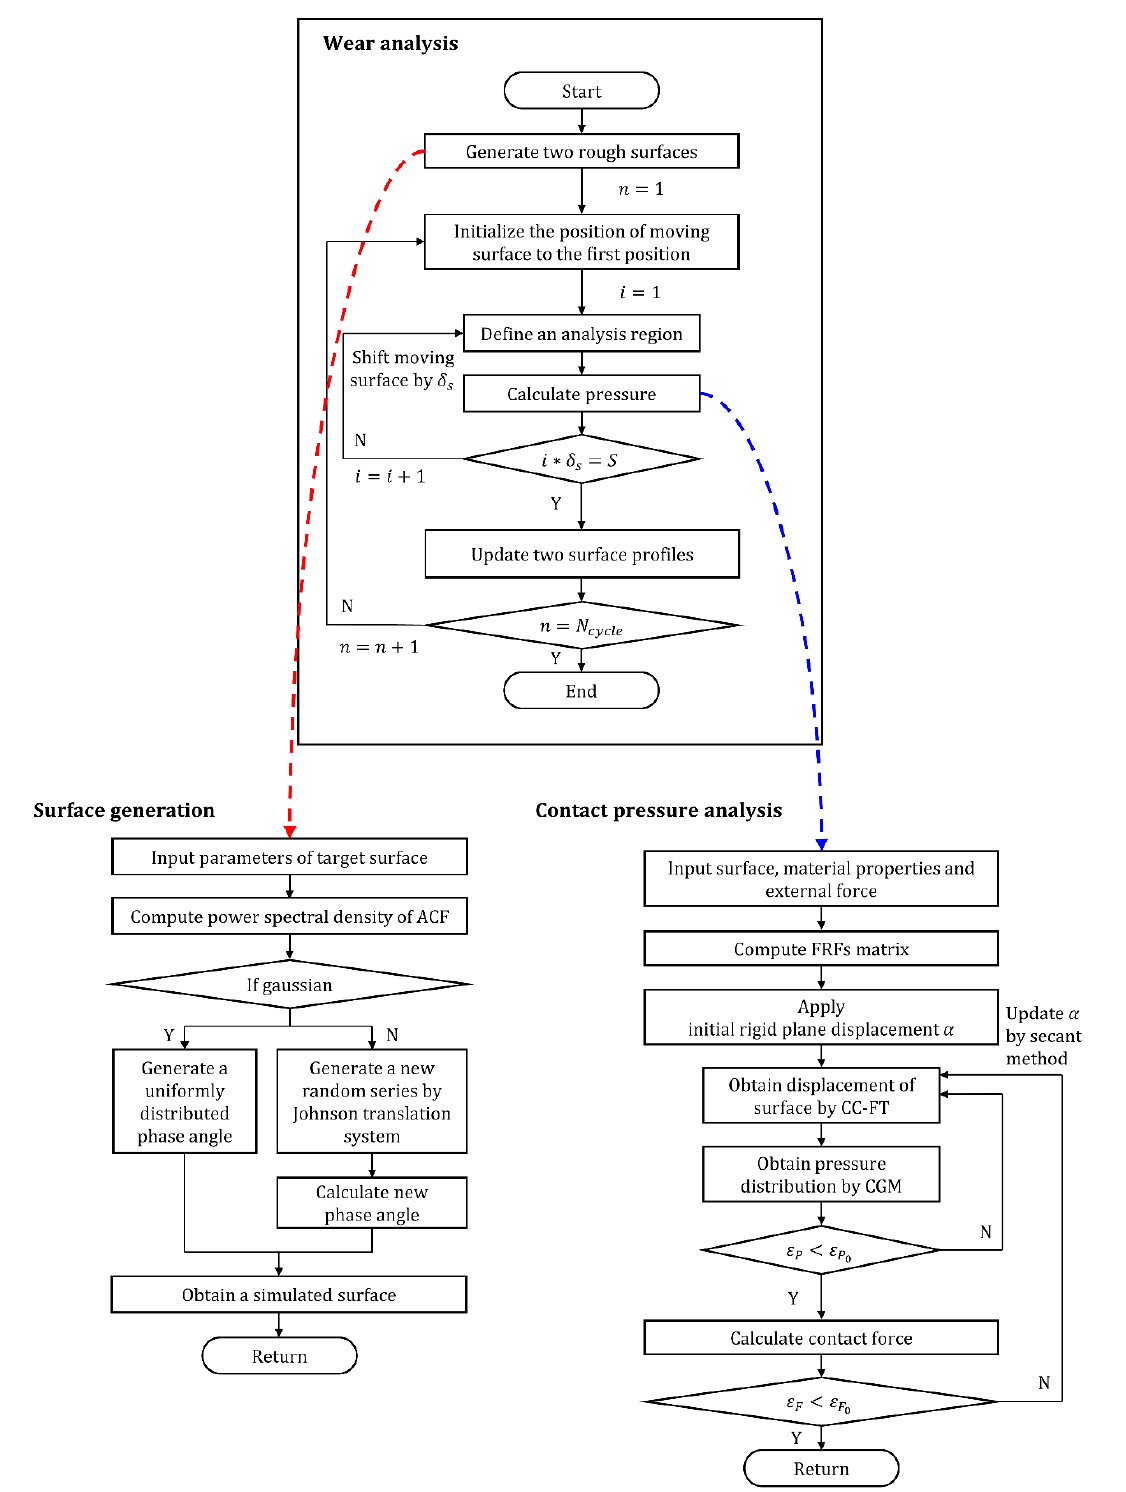
Figure 3. Flowchart of numerical analysis for rough surface wear using deterministic quasi-static wear model.